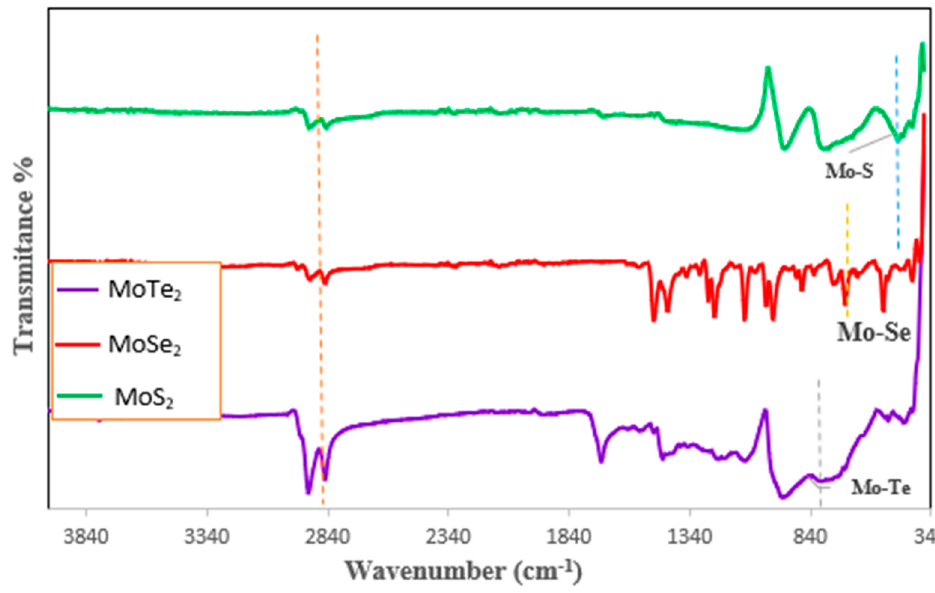
Figure 3. FTIR spectra for the MoX 2 nanoparticles synthesized from two-source precursors.